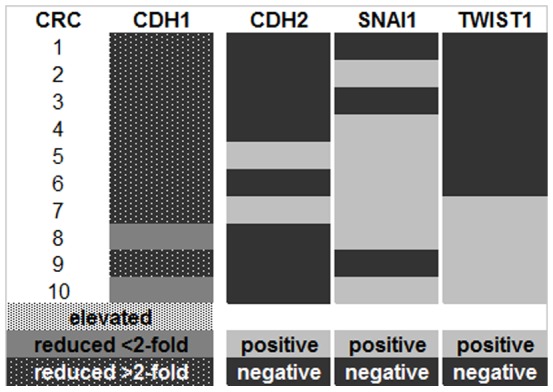
Expression profile of carcinomas in the qRT-PCR.CDH1: up- and downregulation compared to normal colonic mucosa.